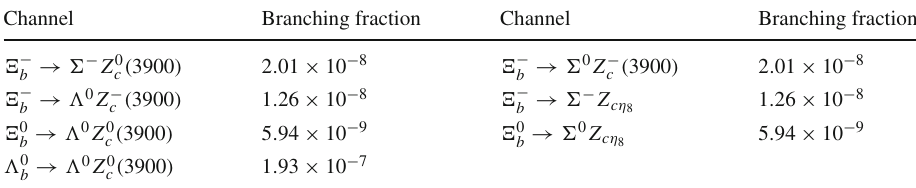
Table 4 Estimation of branching fractions of b-baryon decay in which the tetraquark appears in the final